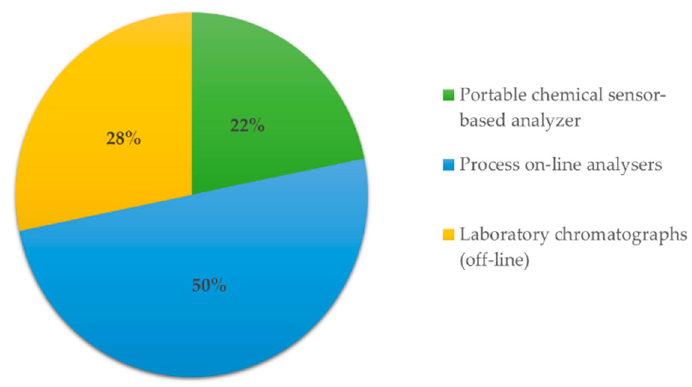
Figure 2. Degree of utilization of various types of devices for monitoring THT concentration in gas within the PSG Sp. z o.o. area.